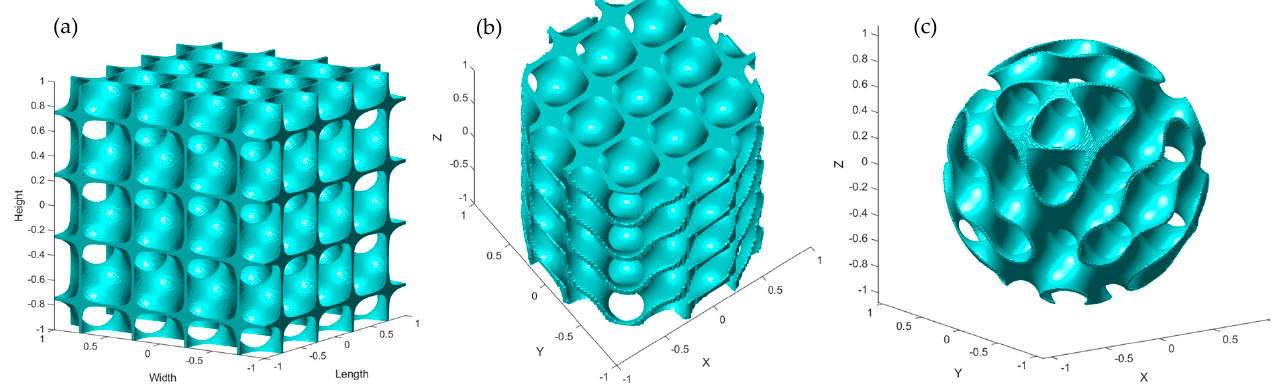
Figure 2. TPMS created on the basis of the Schwartz diamond minimal surface in a limited space: ( a ) cuboid, ( b ) cylinder, ( c ) sphere.